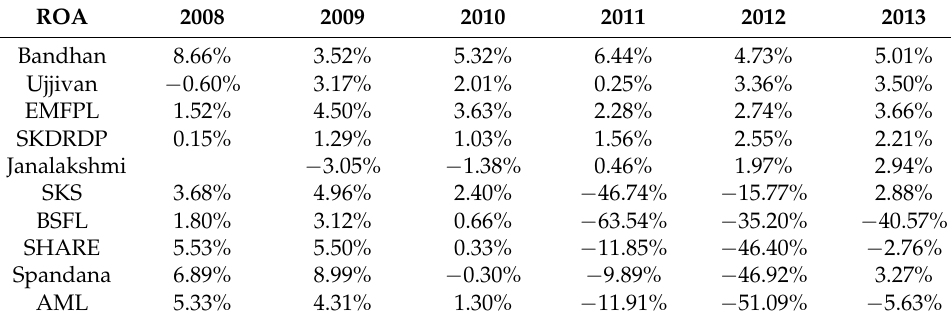
Table 1. ROA of Top Indian